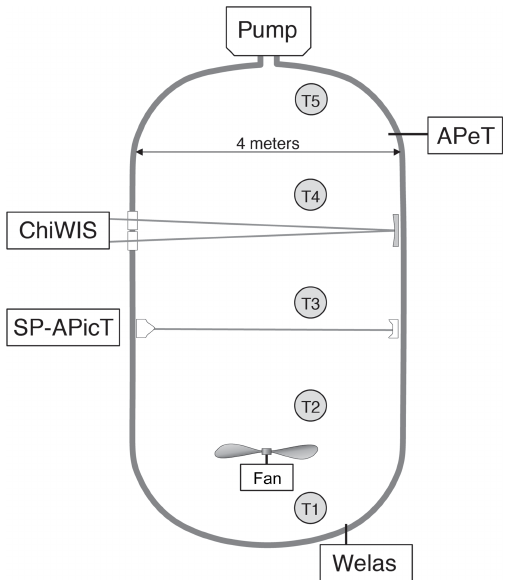
Figure 1. Layout of the instruments used in this analysis during the IsoCloud campaigns at the AIDA chamber. ChiWIS and SP-APicT, both open-path tunable diode laser absorption spectroscopy (TD- LAS) instruments, provided water vapor measurements. APeT, an extractive TDLAS instrument with a heated inlet, provided total water (ice + vapor) measurements, and Welas provided ice particle concentrations. The difference between total water and water vapor measurements was used to calculate ice mass in the chamber. Gas temperature is taken as the average of thermocouples 1 through 4. Thermocouple 5 is excluded from the analysis due to the presence of a region of warm air at the top of the chamber. The whole chamber is within a thermally controlled housing that sets the base tempera- ture of an experiment. The pumps draw gas out of the chamber in a pseudo-adiabatic